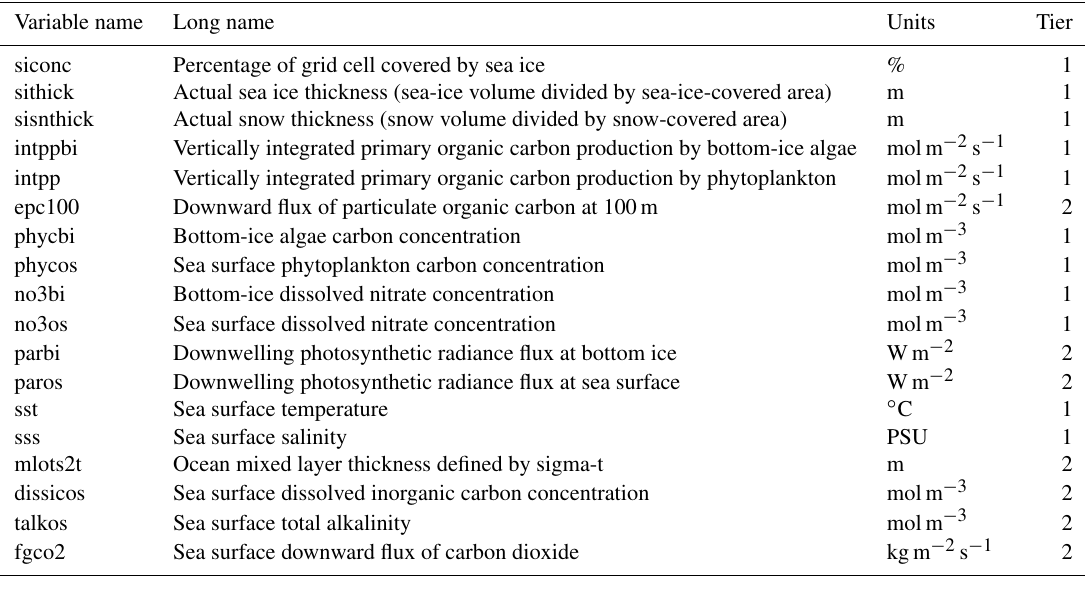
Table 2. List of model diagnostics for IAMIP2. Where applicable, variable names and units follow the CMIP6 convention (https://cmip6dr. github.io/Data_Request_Home last access: 2 November 2021). Tiers refer to mandatory (Tier 1) and optional (Tier 2).